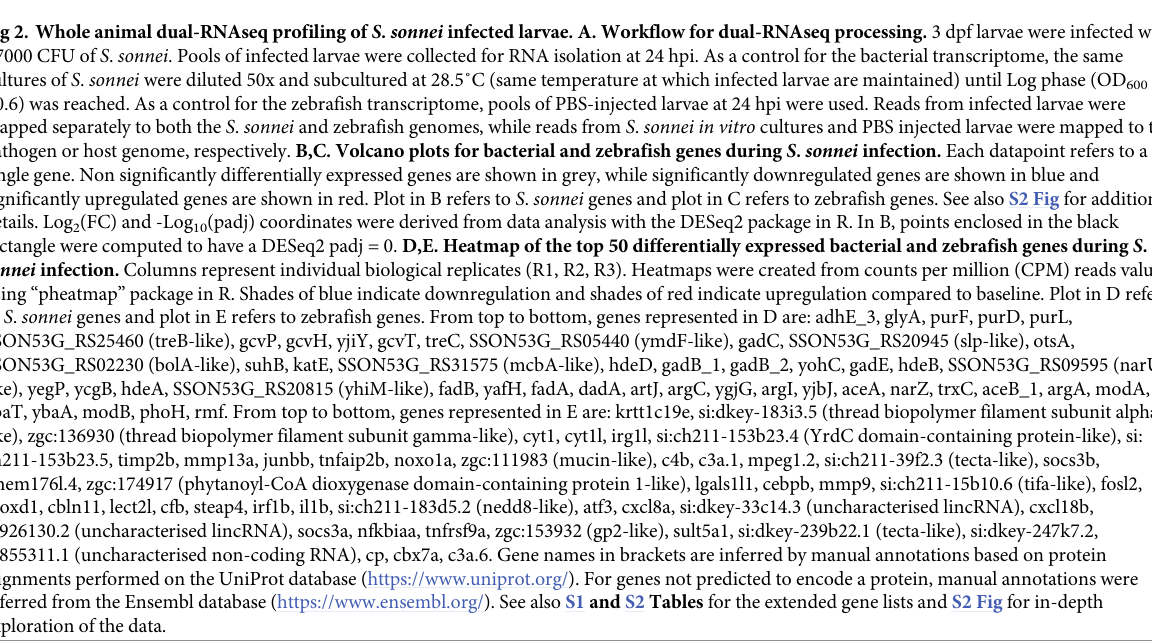
Fig 2. Whole animal dual-RNAseq profiling of S . sonnei infected larvae. A. Workflow for dual-RNAseq processing. 3 dpf larvae were infected with ~7000 CFU of S . sonnei . Pools of infected larvae were collected for RNA isolation at 24 hpi. As a control for the bacterial transcriptome, the same cultures of S . sonnei were diluted 50x and subcultured at 28.5˚C (same temperature at which infected larvae are maintained) until Log phase (OD 600 ~0.6) was reached. As a control for the zebrafish transcriptome, pools of PBS-injected larvae at 24 hpi were used. Reads from infected larvae were mapped separately to both the S . sonnei and zebrafish genomes, while reads from S . sonnei in vitro cultures and PBS injected larvae were mapped to the pathogen or host genome, respectively. B,C. Volcano plots for bacterial and zebrafish genes during S . sonnei infection. Each datapoint refers to a single gene. Non significantly differentially expressed genes are shown in grey, while significantly downregulated genes are shown in blue and significantly upregulated genes are shown in red. Plot in B refers to S . sonnei genes and plot in C refers to zebrafish genes. See also S2 Fig for additional details. Log 2 (FC) and -Log 10 (padj) coordinates were derived from data analysis with the DESeq2 package in R. In B, points enclosed in the black rectangle were computed to have a DESeq2 padj = 0. D,E. Heatmap of the top 50 differentially expressed bacterial and zebrafish genes during S . sonnei infection. Columns represent individual biological replicates (R1, R2, R3). Heatmaps were created from counts per million (CPM) reads values, using “pheatmap” package in R. Shades of blue indicate downregulation and shades of red indicate upregulation compared to baseline. Plot in D refers to S . sonnei genes and plot in E refers to zebrafish genes. From top to bottom, genes represented in D are: adhE_3, glyA, purF, purD, purL, SSON53G_RS25460 (treB-like), gcvP, gcvH, yjiY, gcvT, treC, SSON53G_RS05440 (ymdF-like), gadC, SSON53G_RS20945 (slp-like), otsA, SSON53G_RS02230 (bolA-like), suhB, katE, SSON53G_RS31575 (mcbA-like), hdeD, gadB_1, gadB_2, yohC, gadE, hdeB, SSON53G_RS09595 (narU- like), yegP, ycgB, hdeA, SSON53G_RS20815 (yhiM-like), fadB, yafH, fadA, dadA, artJ, argC, ygjG, argI, yjbJ, aceA, narZ, trxC, aceB_1, argA, modA, ybaT, ybaA, modB, phoH, rmf. From top to bottom, genes represented in E are: krtt1c19e, si:dkey-183i3.5 (thread biopolymer filament subunit alpha- like), zgc:136930 (thread biopolymer filament subunit gamma-like), cyt1, cyt1l, irg1l, si:ch211-153b23.4 (YrdC domain-containing protein-like),